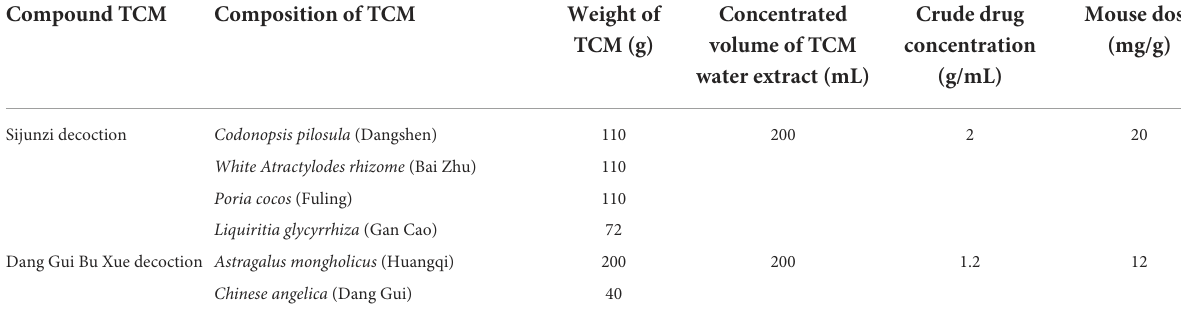
TABLE 2 Compound TCM gavage dose for mouse treatment. Compound TCM Composition of